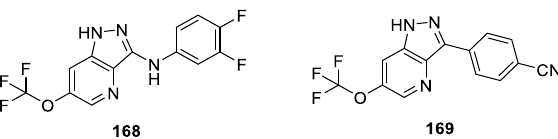
Figure 51. Chemical structures of 1 H -indazole derivatives 168 and 169 .